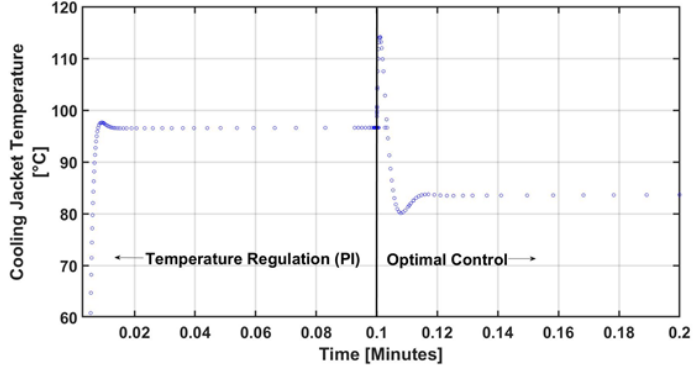
Figure 3. Control effort for temperature regulation.